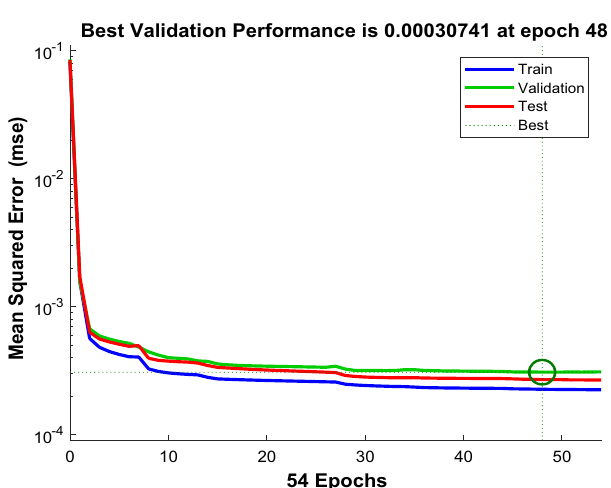
Figure 6. Training performance in terms of MSE showing the best validation at epoch